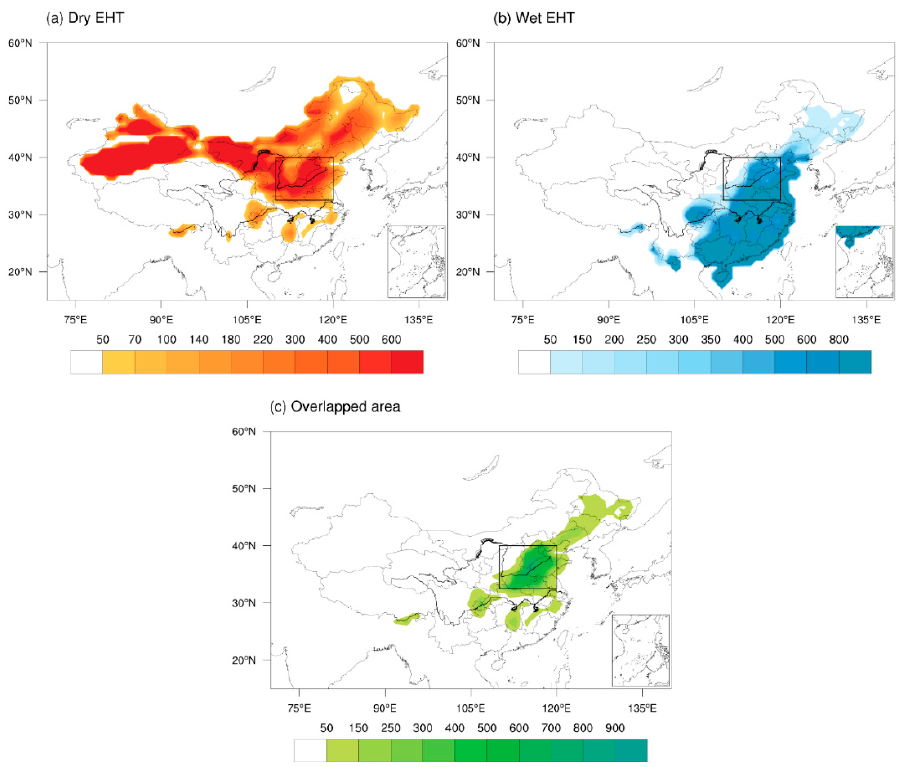
Figure 1. The sum of EHT frequency distribution of dry and wet in China from 1961 to 2016 in summer (June-august) (unit: day). ( a ) Dry EHT area, ( b ) wet EHT area, ( c ) overlapped area. Black box (32.5 ◦ –45 ◦ N, 110 ◦ –120 ◦ E) indicates the regions of the MLRYR. The value in ( c ) is the minimum of dry and wet EHT days.